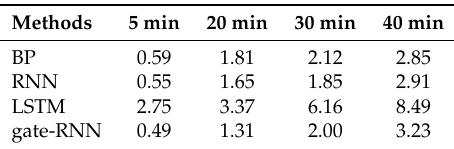
Table 8. Results of the MAPE for different time